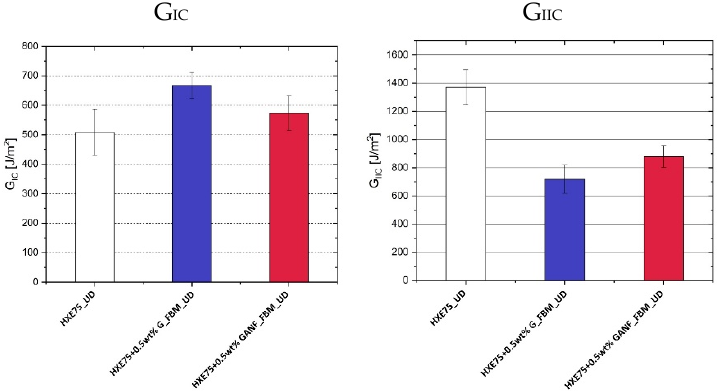
Figure 11. Flexural test results of the composites under examination.